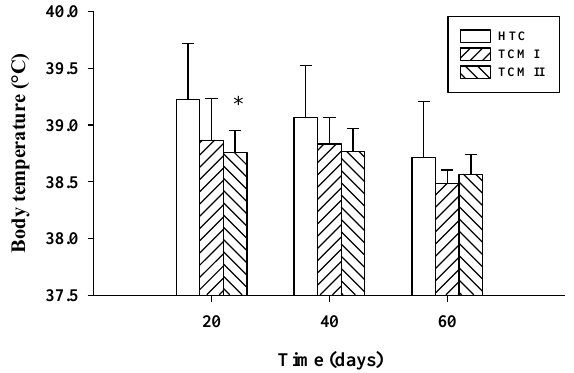
Figure 2. Effects of TCM I and TCM II treatments on body temperature of heat stressed beef cattle; * p<0.05, compared with HTC group. TCM I = traditional Chinese medicine prescriptions I+high temperature; TCM II = traditional Chinese medicine prescriptions II+high temperature; HTC, high temperature